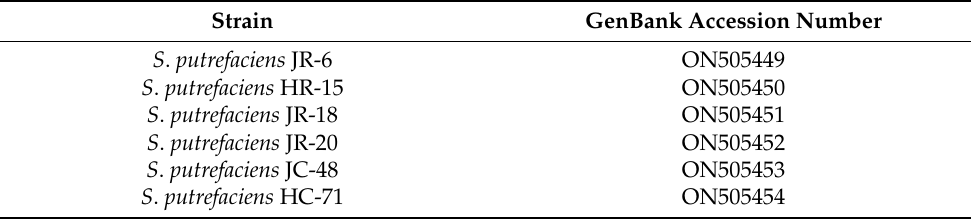
Table 1. The GenBank accession numbers of the nucleotide sequence of the experimental strain.